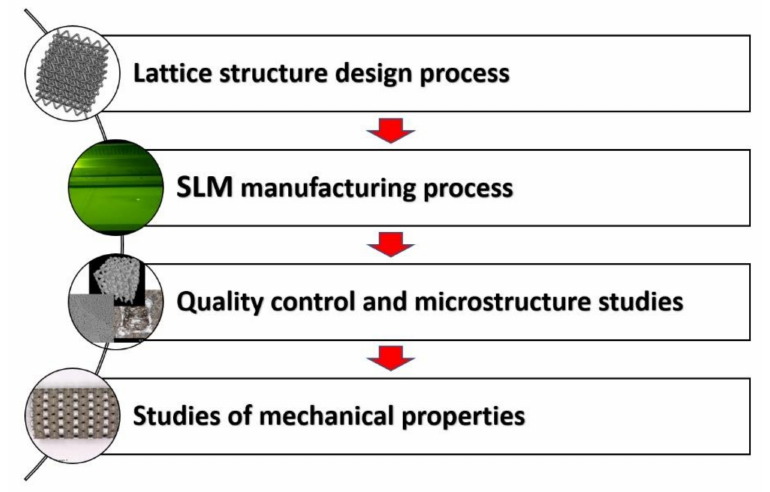
Figure 1. The main steps of the conducted investigation